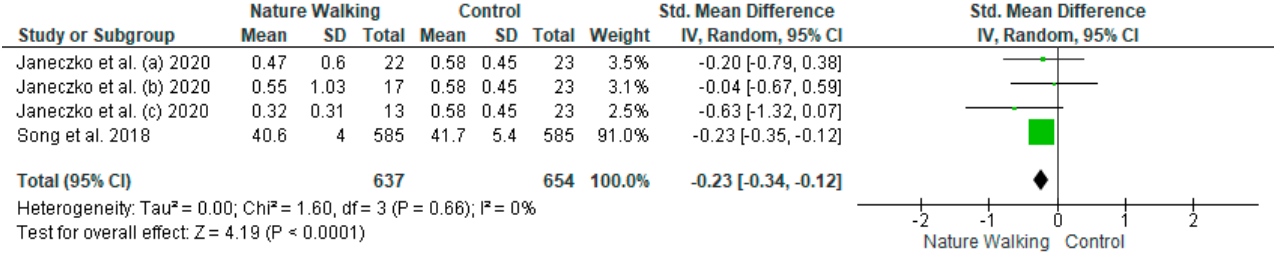
Figure 4. Depression Nature Walk vs. Control Forest Plot [11,13]. Green squares represent stand- ardized mean difference for each study, while black rhombus represents the aggregated average of the standardized mean differences.